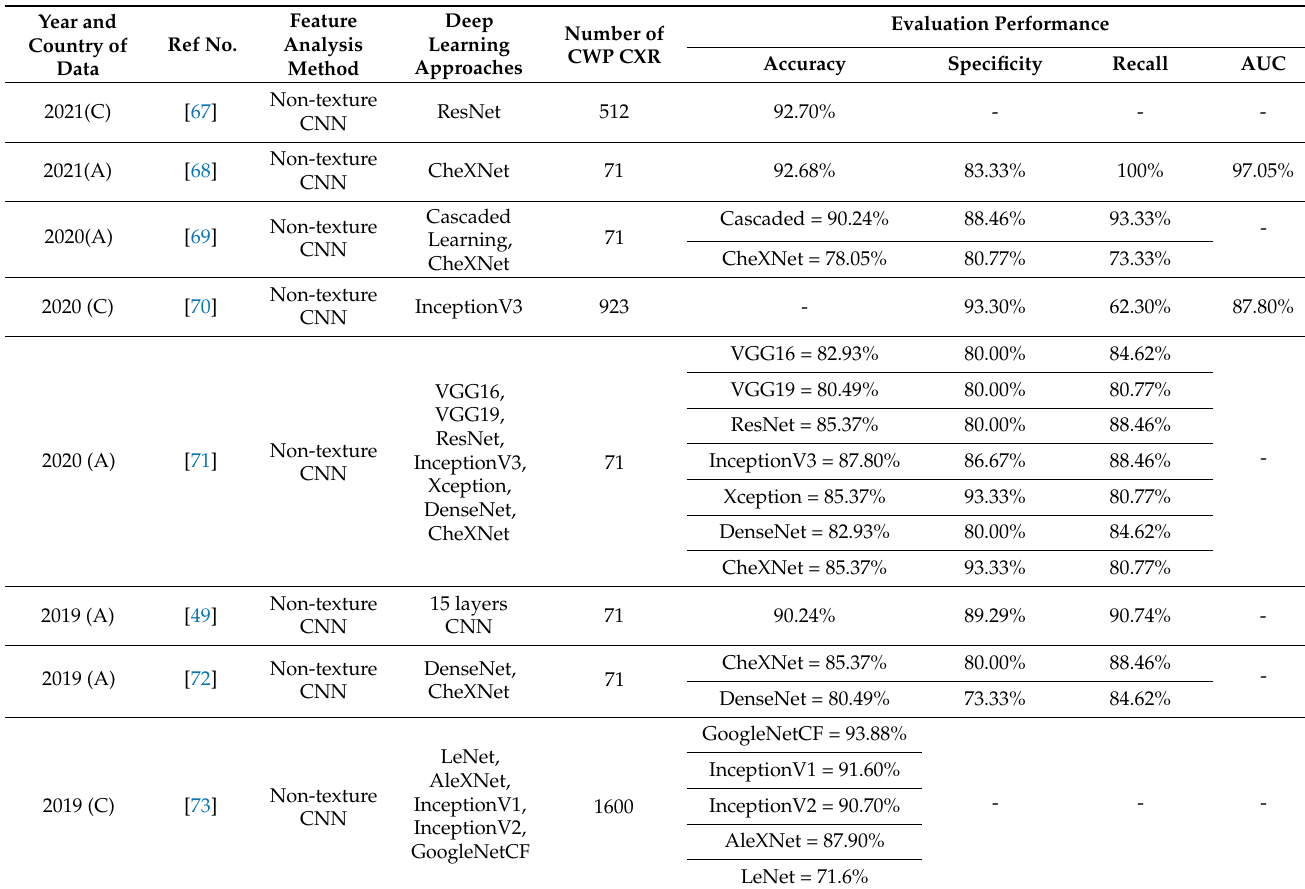
Table 4. Summary of deep learning approaches included